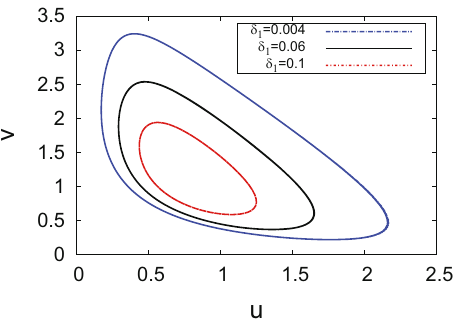
Figure 11: Phase plane u v − illustrating the limit cycle curves for di ff erent values of δ 0.004, 0.06 1 = , and 0.1. Other parameters are as in Figure